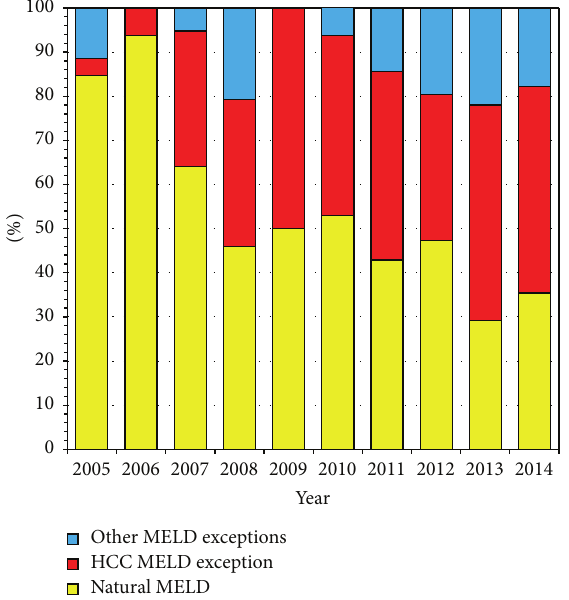
Figure 5: Percentage of adult LT in Alberta transplanted according to natural MELD versus exception points for HCC or other indica- tions since adopting MELD based